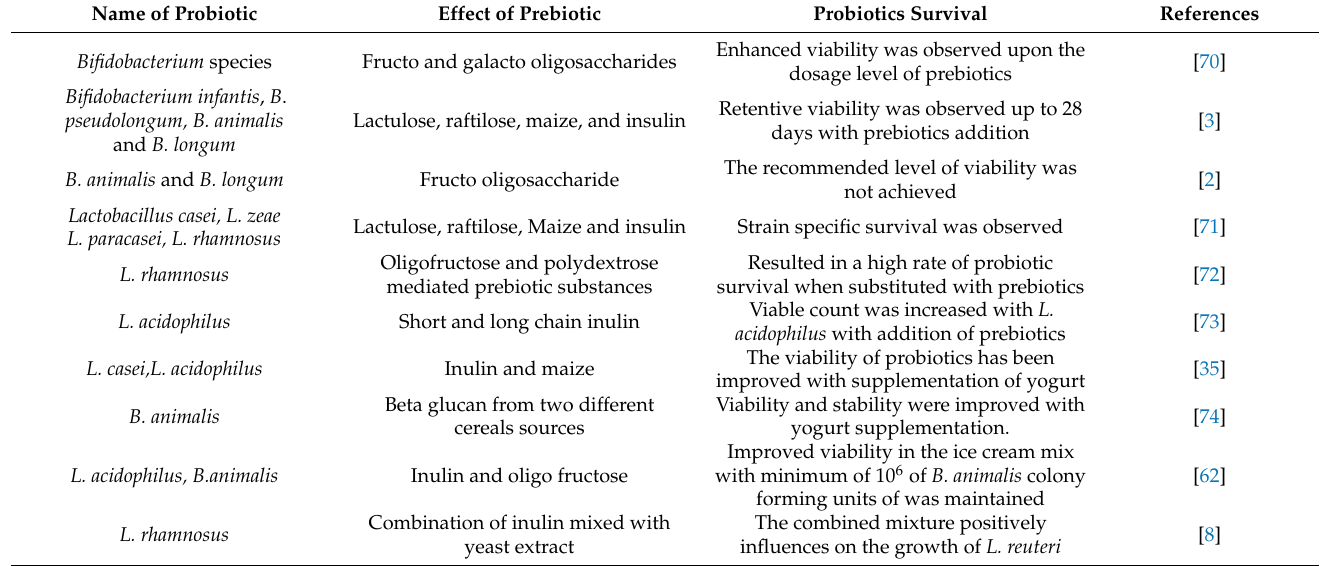
Table 1. Effect of prebiotics on viability of